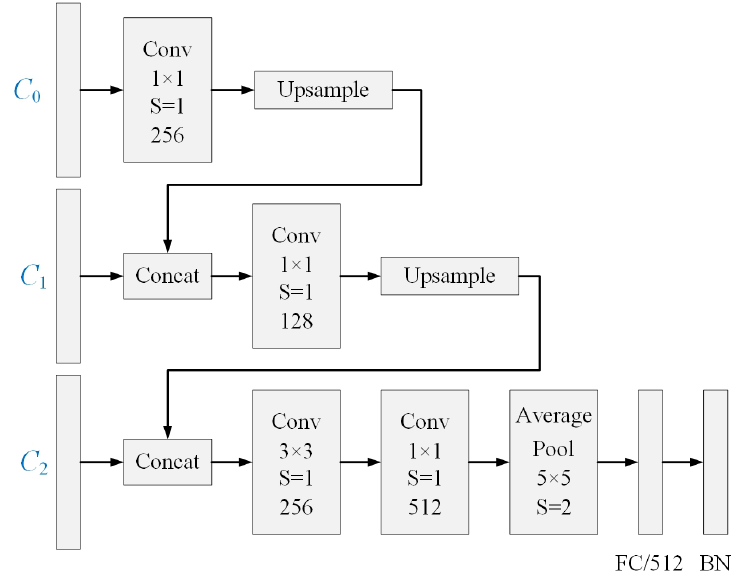
Figure 9. Multi-layer feature fusion structure